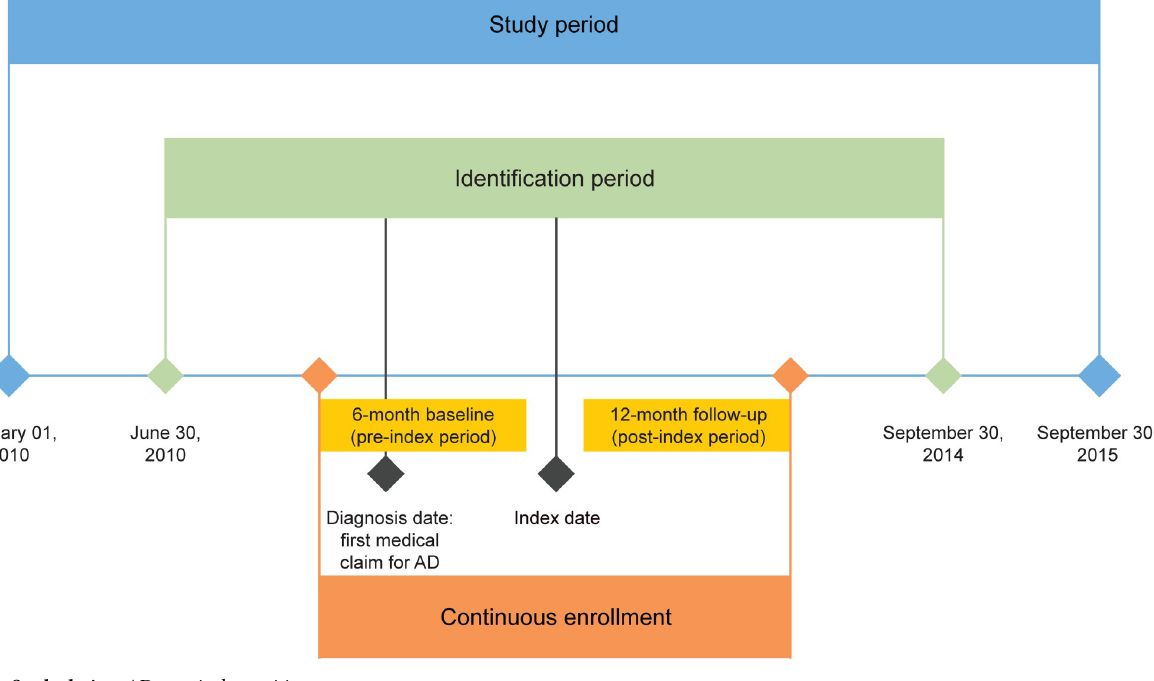
Fig 1. Study design. AD, atopic